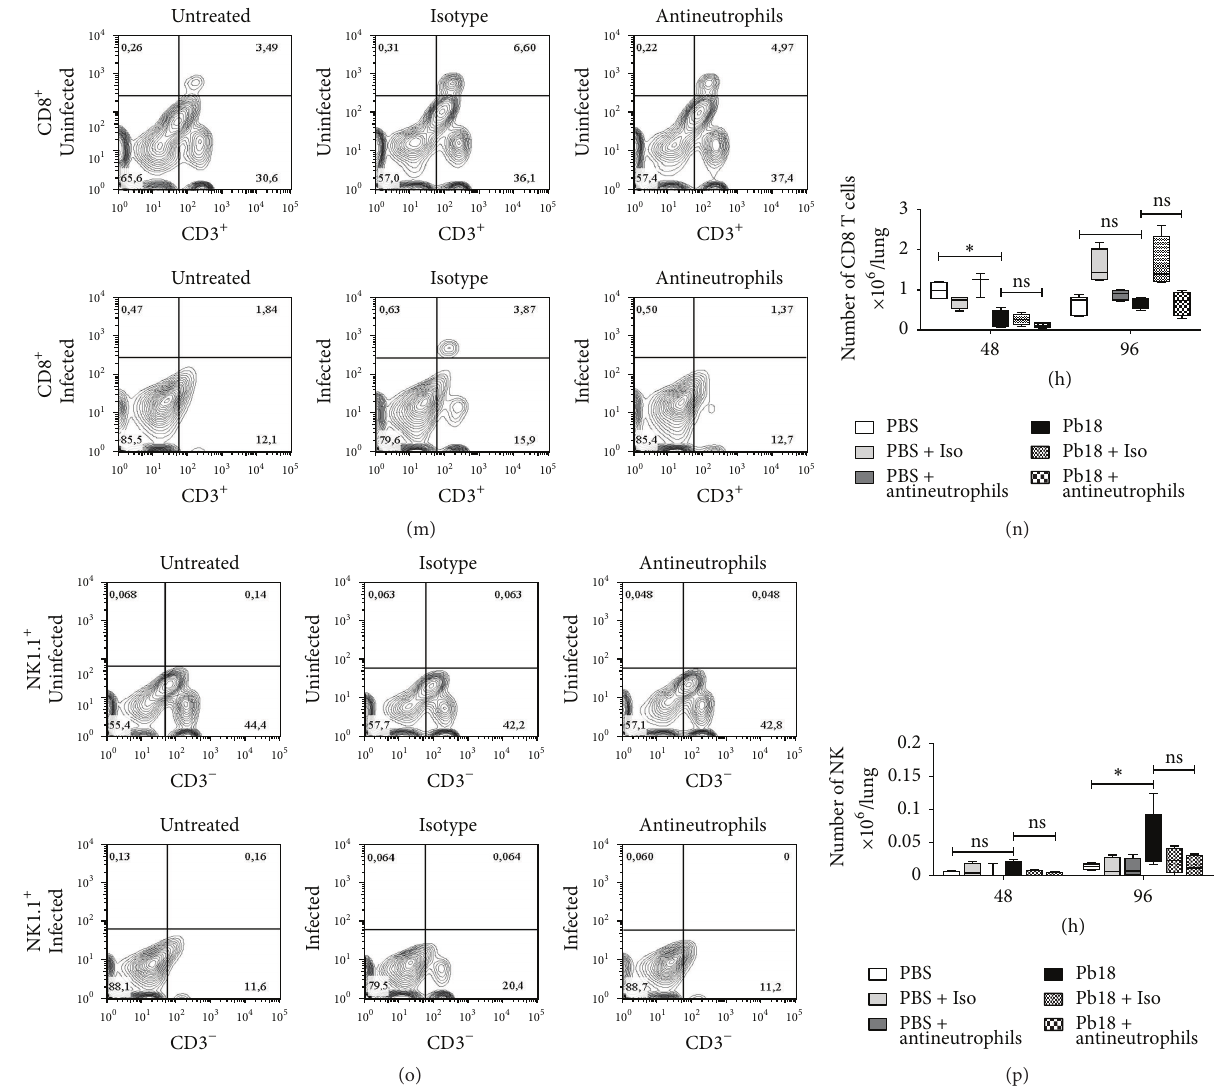
Figure 3: The anti-Ly6G mAb depletes specifically neutrophils and leads to an increased number of eosinophils during the acute stages of P. brasiliensis infection. BALB/c mice were intranasally inoculated with PBS or 1.5 × 10 6 P. brasiliensis (Pb18) yeast cells, treated with an isotype control Ab or the anti-Ly6G specific mAb against neutrophils, and analyzed during the acute phase of P. brasiliensis infection (48h and 96 h after challenge). Cell populations from lungs of mice were assessed by flow cytometry as described in the Materials and Methods section. Representative flow cytometry contour plots of pulmonary cells within the gated CD45+ subpopulations are shown as (a) eosinophils, (c) alveolar macrophages, (e), tissue macrophages, (g) DCs, (i) B cells, (k) CD4 T cells, (m) CD8 T, and (o) NK cells at 96 h after infection. Numbers inside the gates indicate the mean percentages of the gated subsets. Bar plots of the respective cell subpopulation per lung are shown (b, d, f, h, j, l, n, and p). Data shown represent median and IQR ( 𝑛 = 4 -5 mice/group; representative of two independent experiments). ∗ 𝑃 < 0.05 comparing infected-untreated mice versus control mice or comparing infected-anti-Ly6G mAb-treated mice versus infected- untreated mice. PBS, control mice; PBS + Iso, control mice treated with isotype control Ab (clone: 2A3); PBS + antineutrophils, control mice treated with anti-Ly6G mAb (clone: 1A8); Pb18, infected-untreated mice; Pb18 + Iso, infected mice treated with isotype control Ab; Pb18 + antineutrophils, infected mice treated with anti-Ly6G mAb; ns: not